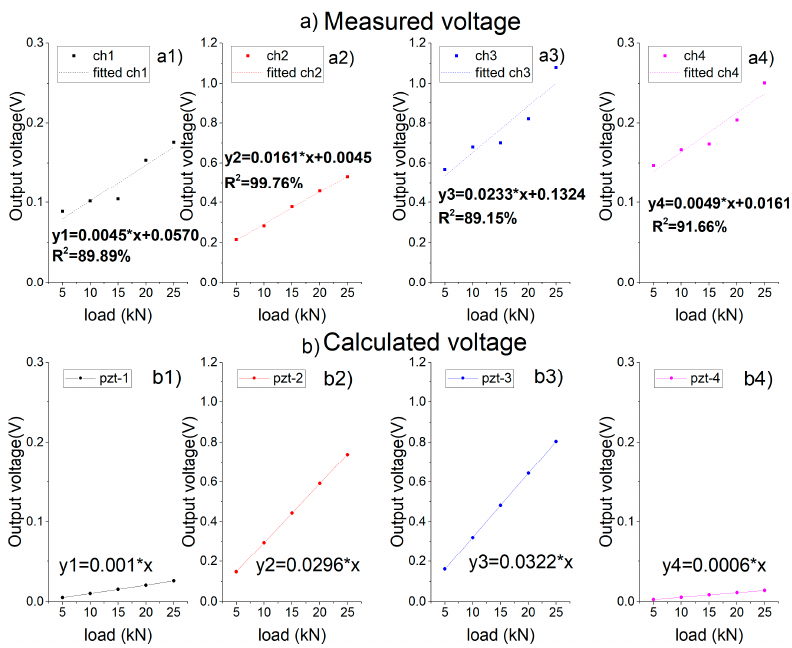
Figure 21. Comparison of measured and calculated values of each unit’s output at 10 Hz loading frequency. ( a ) measured results; ( b ) calculated results based on the stress value from the simulation.